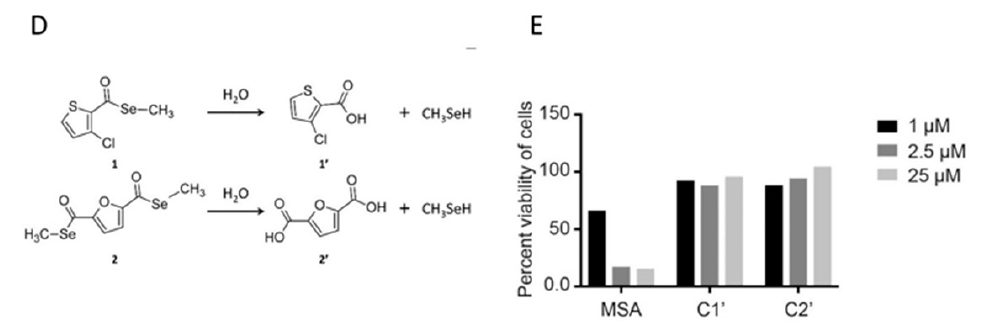
Figure 2. Compounds 1 and 2 and MSA decrease cell viability in 2D and 3D Panc-1 cultures. ( A ) Panc-1 cells (2D cultures) were treated with different concentrations of the compounds for 72 h followed by the determination of cell viability by the MTT (3-(4,5-Dimethylthiazol-2-yl)-2,5-Diphenyltetrazolium Bromide) assay. Results represent mean ± SEM of at least three independent experiments performed in quadruplicate. ( B ) Panc-1 spheroids (3D cultures) were treated with different concentrations of the compounds for 72 h, after which cell viability was determined using the acid phosphatase (APH) assay. Results represent mean ± SEM of at least three independent experiments performed in quadruplicate. ( C ) Representative confocal images of Panc-1 spheroids stained with Hoechst 33342 and PI after 72 h treatment with 7.5 µ M and 25 µ M of respective compounds. 10 × objective magnification images were acquired from the Operetta ® High-Content Imaging System and processed by Colombus™ analysis software. The adjacent graph represents a quantitative analysis of PI/Hoechst fluorescence. Results represent mean ± SEM ( n = 4). ( D ) Potential hydrolysis reaction of compounds 1 and 2 . ( E ) 2D cell viability after treatment with the corresponding carboxylic acid for 72 h. Statistical significance compared to control: * p < 0.05, *** p <